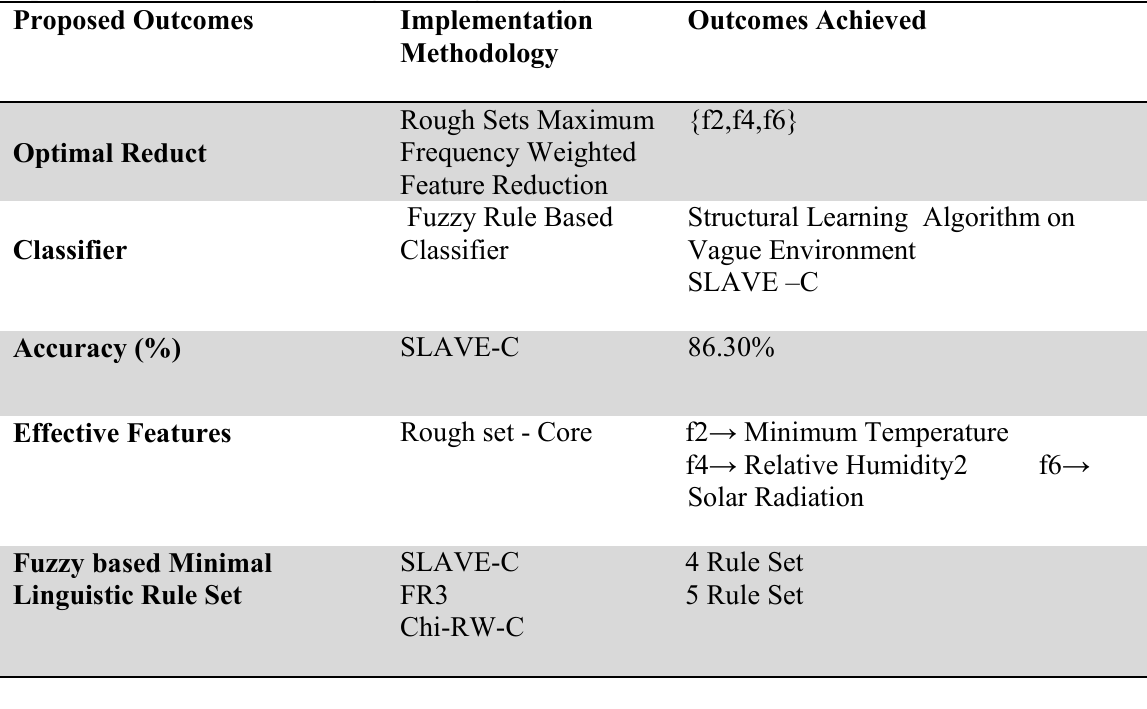
Experimental Outcome of Intelligent Rough Fuzzy